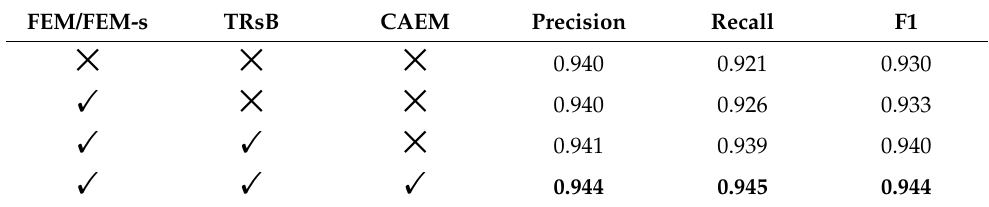
Table 4. Comparison results of different feature fusion pyramids, in which the FEM and TRsB modules are not used in